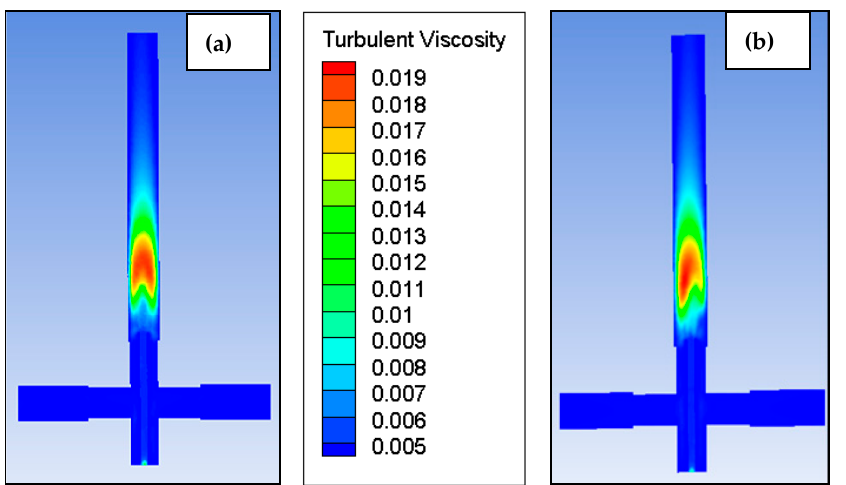
Figure 5. Turbulence viscosity (kg/m · s) distribution comparisons obtained at the reactor center face (x = 0, y = 0) where ( a ) using surface growth only model for crystallization and ( b ) using combined aggregation and surface growth model, respectively.